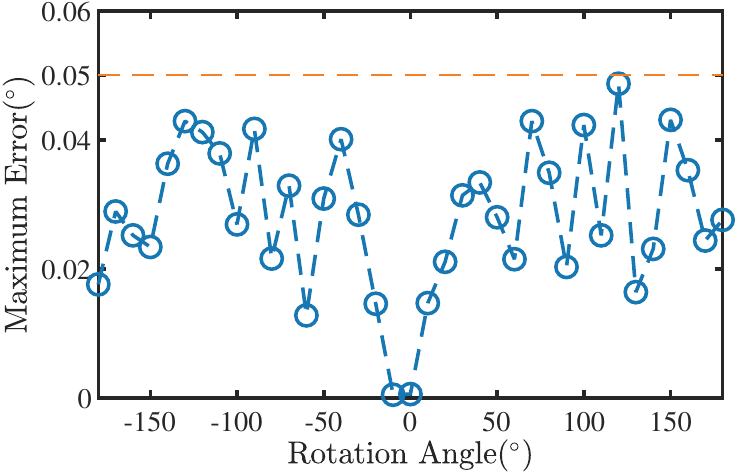
Figure 14. Maximum measurement error of RAMS for various